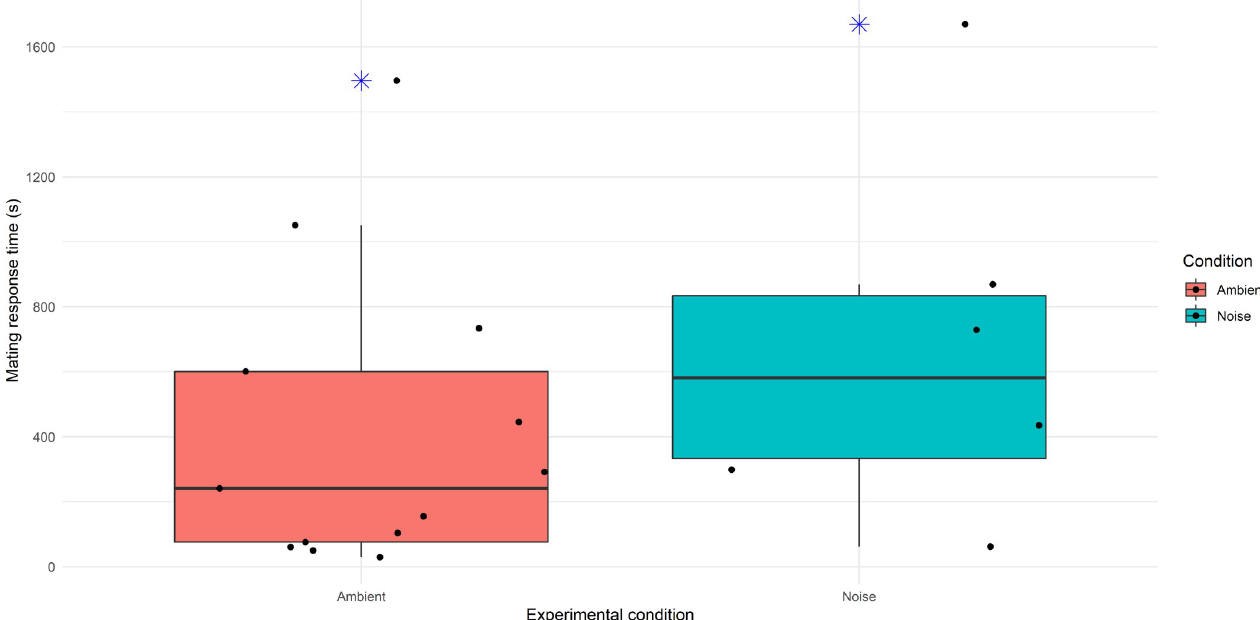
Fig 5. Boxplot comparing the median (horizontal line dividing the boxes), mean (x), range (upper and lower whiskers), 25% (lower box boundary) and 75% quartiles (upper box boundary), outliers (asterisks) and jittered points (dots) for crab mating response times in seconds under noise (n = 6) and ambient conditions (n =